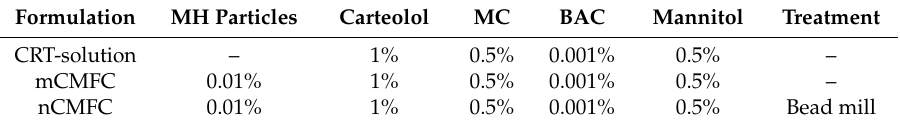
Table 3. Formulation in CRT-solution, mCMFC, and